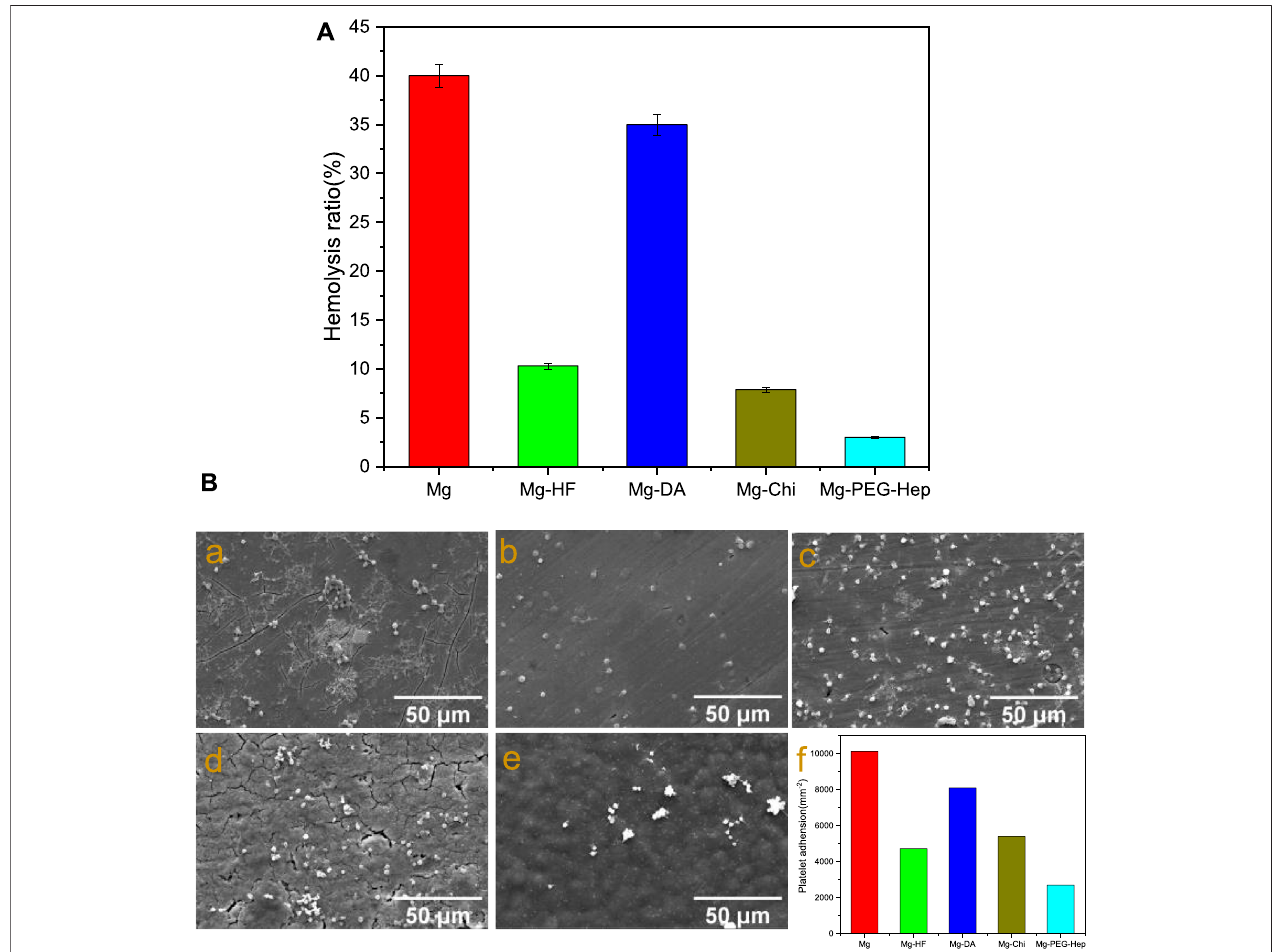
FIGURE 5 | (A) Hemolysis rate of the different samples. (B) SEM images of platelet adhesion on the different samples. (a) Mg, (b) Mg-HF, (c) Mg-DA, (d) Mg-Chi, (e) Mg-PEG-Hep, (f) The number of the attached platelets on the different samples.